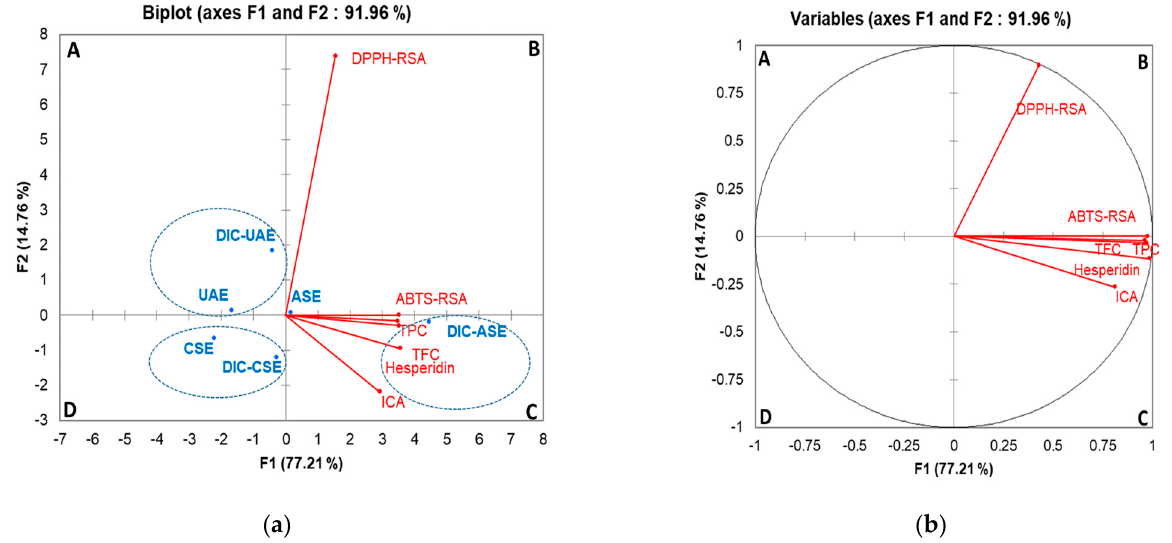
Figure 5. PCA biplot of different extraction methods and measured variables; observations circled in blue indicate distinguished groups ( a ). Biplots of the measured variables: antioxidant activities, and phenol, flavonoid, and hesperidin contents of orange-by products ( b ). A–D are the quadrants of the PCA biplot. CSE-conventional solvent extraction, UAE-ultrasound-assisted extraction, ASE- accelerated solvent extraction, DIC-instant controlled pressure drop. Table 1. Pearson correlation matrix of TPC, TFC, hesperidin content, and antioxidant activities.